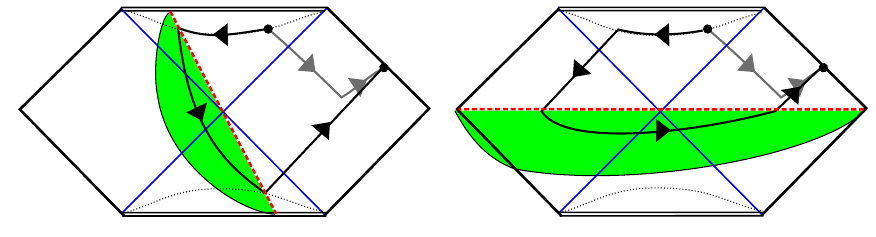
Fig. 6 Left: the calculation trick by Hartle and Hawking. Right: due to analyticity, we can choose different path. Then this will give the same results of the instanton